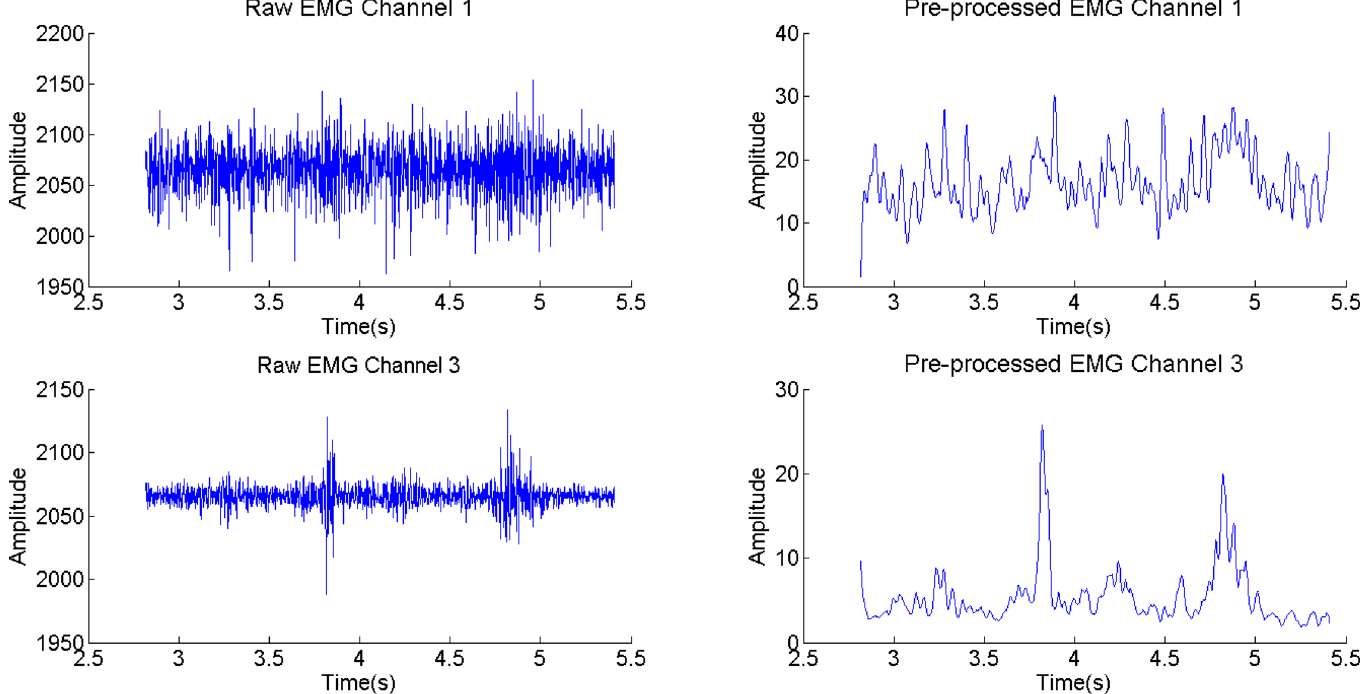
Fig 7. Raw EMG signal and pre-processed EMG signal of channel 1 (top) and 3 (bottom) for the sentence [6~p6, p6~p6, p6~] from speaker 1. The pre-processed signal has been normalized and filtered using a 12-point moving average filter.